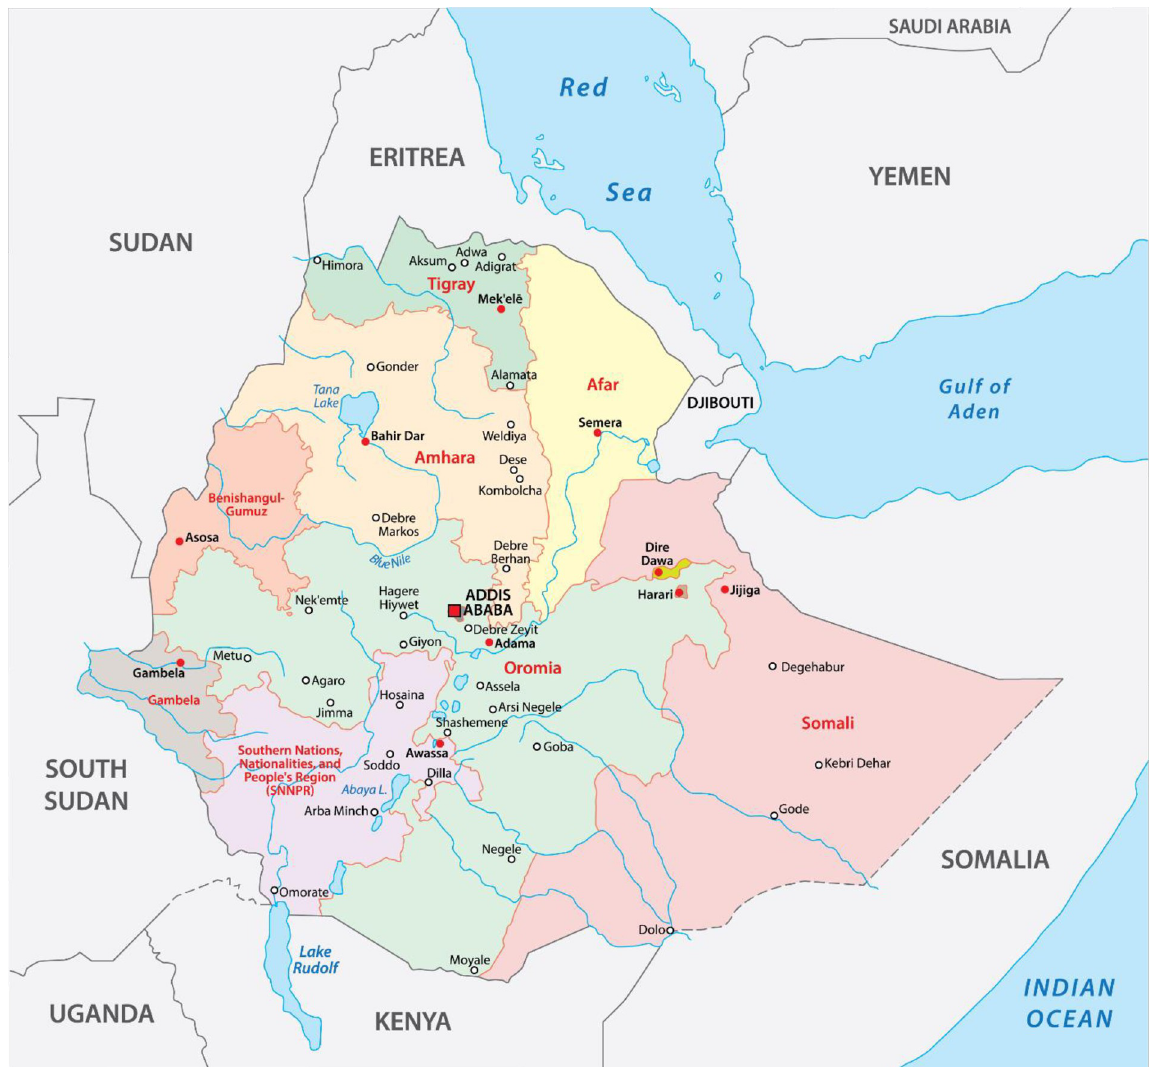
Fig 1. PRISMA flow diagram of the included studies for tinea capitis among schoolchildren in Ethiopia.